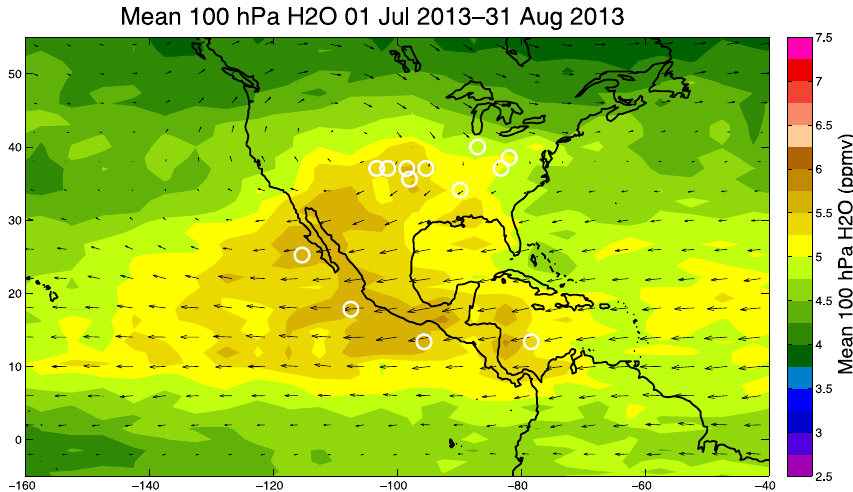
Figure 4. The 2-month mean map of Aura MLS v4.2 100hPa H 2 O (color scale), corresponding to approximately 17km of altitude with superimposed MERRA horizontal winds (arrows) for July–August 2013 during the SEAC 4 RS time period. The MLS observations of 100hPa H 2 O greater than 8ppmv in this 2-month period are shown by the white